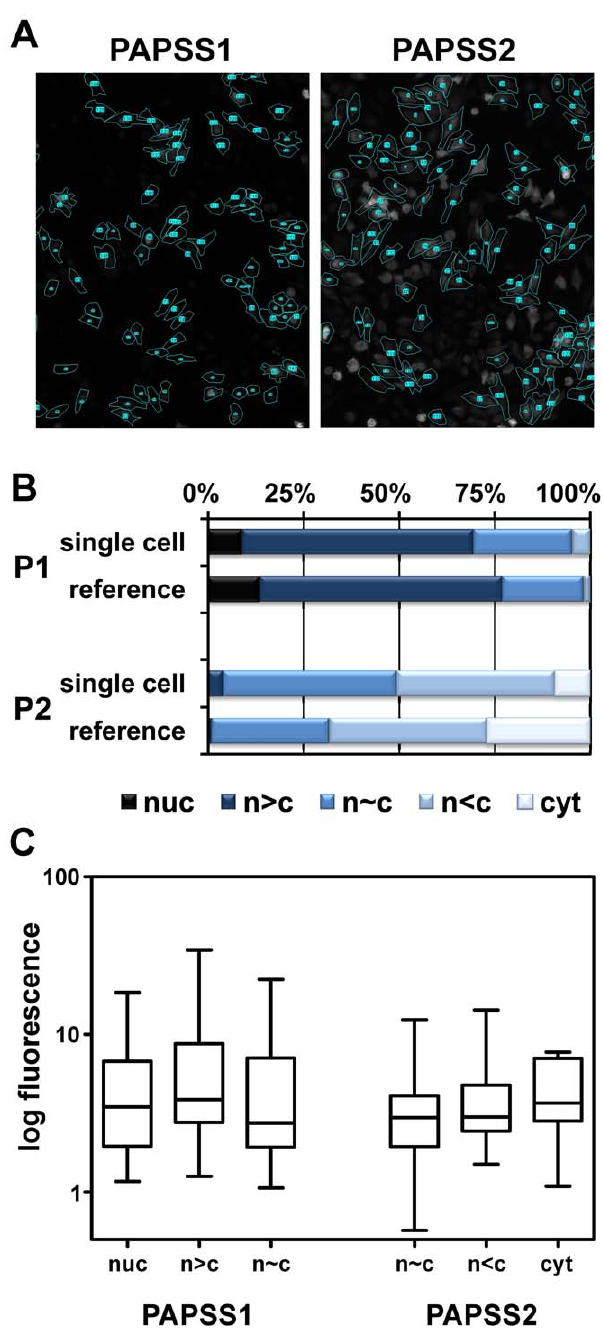
Figure 2. Heterogeneity of localisation does not correlate with PAPS synthase-EGFP expression levels. A , microscopic images of fixed HeLa cells transfected with PAPSS1- and PAPSS2-EGFP fusion plasmids were analysed on a single-cell level using ImageJ